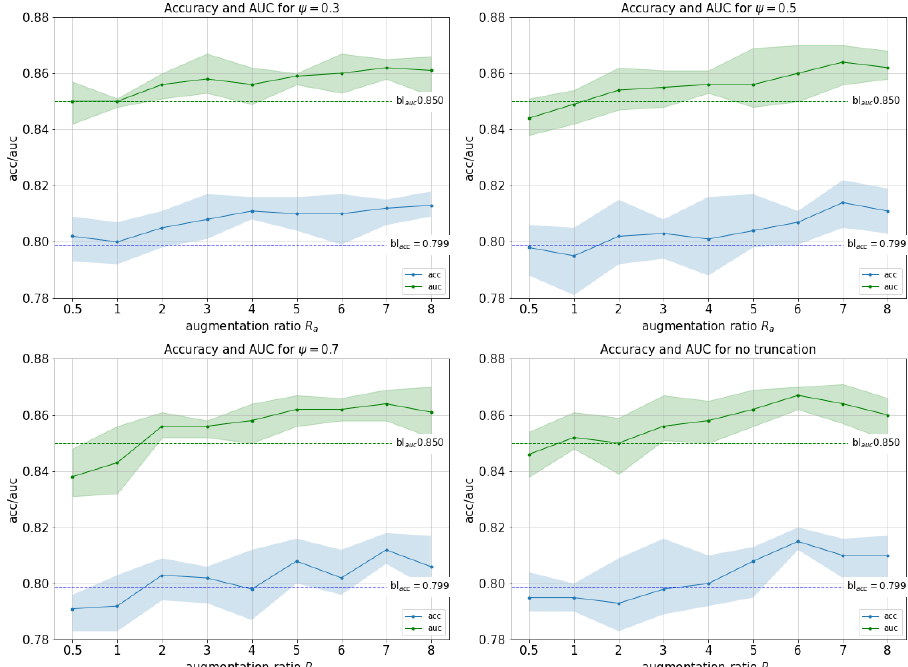
Figure 4. Accuracy (blue, with max and min) and AUC (green, with max and min) for experiments with ψ = 0.3, ψ = 0.5, ψ = 0.7 and ψ = 1 (no truncation). Horizontal lines represent the baseline accuracy and AUC (without GAN data